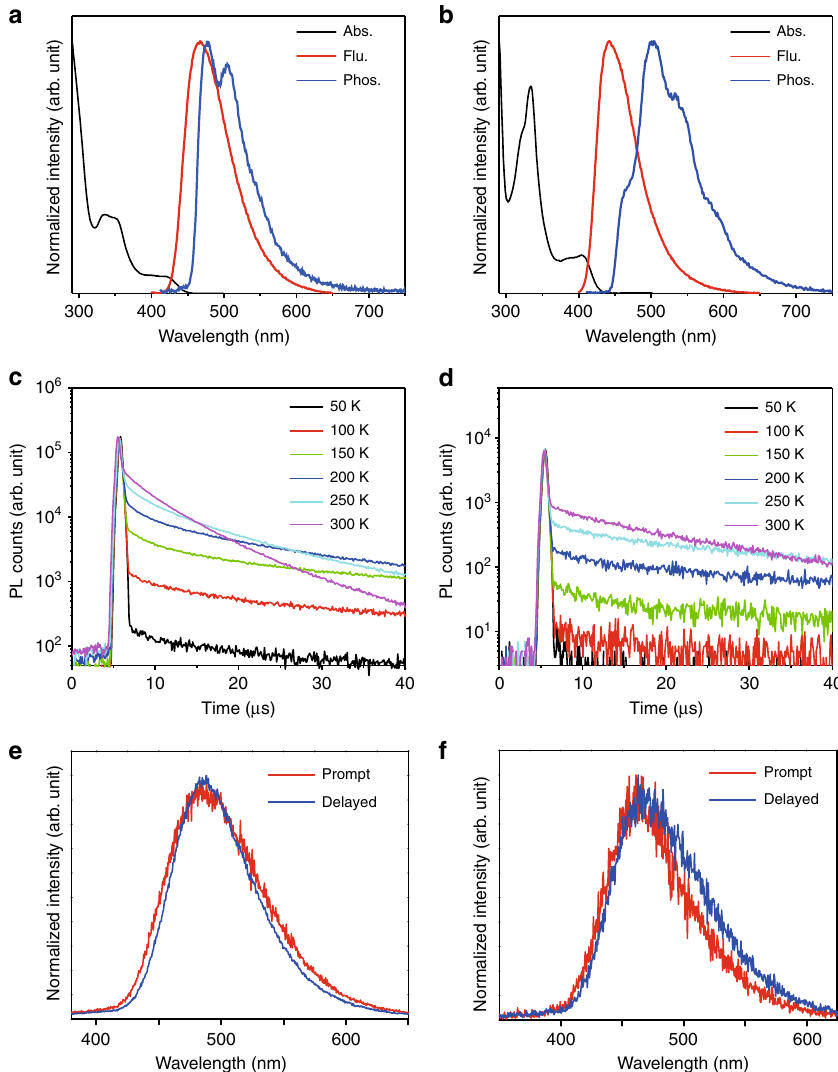
Fig. 2 Photophysical properties of 3Ph 2 CzCzBN and 4CzBN . a Absorption, fl uorescence and phosphorescence spectra of 3Ph 2 CzCzBN in toluene. b Absorption, fl uorescence and phosphorescence spectra of 4CzBN in toluene. c Temperature-dependence transient decay pro fi les of a thin fi lm of 15 wt% of 3Ph 2 CzCzBN doped in mCBP. d Temperature-dependence transient decay pro fi les of a thin fi lm of 15 wt% of 4CzBN doped in mCBP. e Prompt and delayed spectra of a thin fi lm of 15 wt% of 3Ph 2 CzCzBN doped in mCBP. f Prompt and delayed spectra of a thin fi lm of 15 wt% of 4CzBN doped in